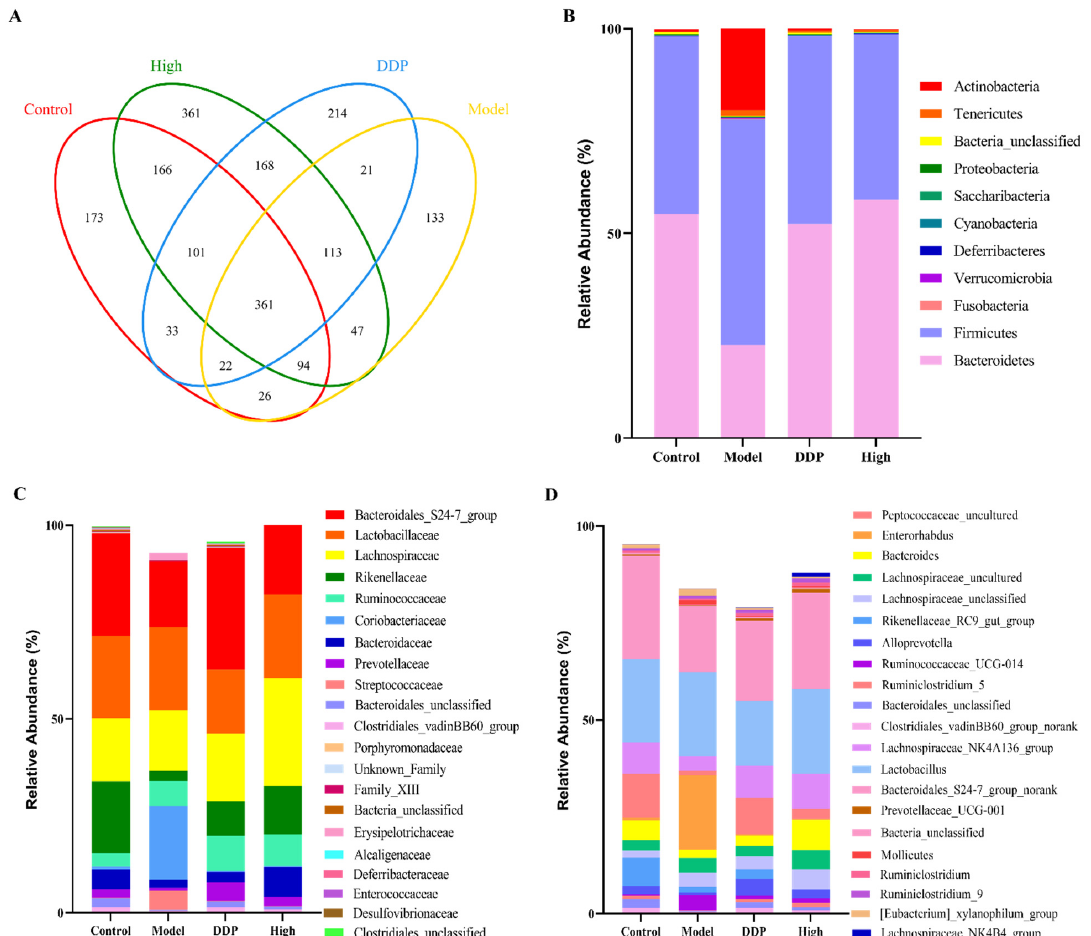
Figure 3 . Analysis of microbiome of colon cancer mice after SCS treatment. Venn diagram illustrat- ing overlap of OTUs ( A ); Microbiota composition at phylum level ( B ), family level ( C ), and genus level ( D ).